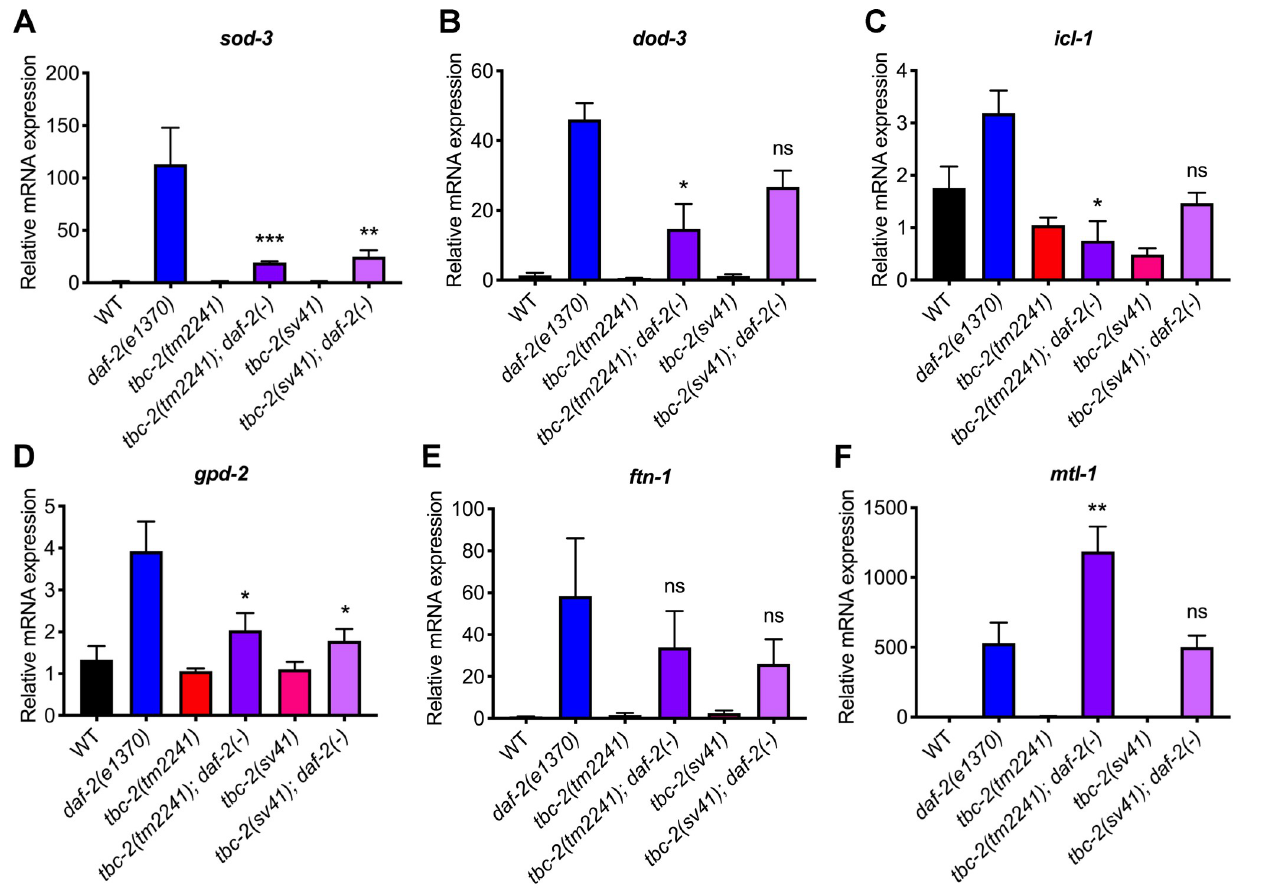
Fig 6. TBC-2 is required for the increased DAF-16 target gene expression resulting from decreased insulin/IGF signaling. Quantitative RT-PCR analysis of DAF-16 target gene expression in wild type, daf-2(e1370) , tbc-2(tm2241) , tbc-2(tm2241); daf-2(e1370) , tbc-2(sv41) , and tbc-2(sv41); daf-2(e1370) . Statistical analysis was performed using an Ordinary one-way ANOVA–Tukey’s multiple comparisons test. Shown are comparisons of tbc-2(tm2241); daf-2(e1370) and tbc-2(sv41); daf-2(e1370) versus daf-2(e1370) single mutants. Raw data is available in S1 Data. ns, not significant. � P < 0.05, �� P < 0.01, ��� P < 0.001.